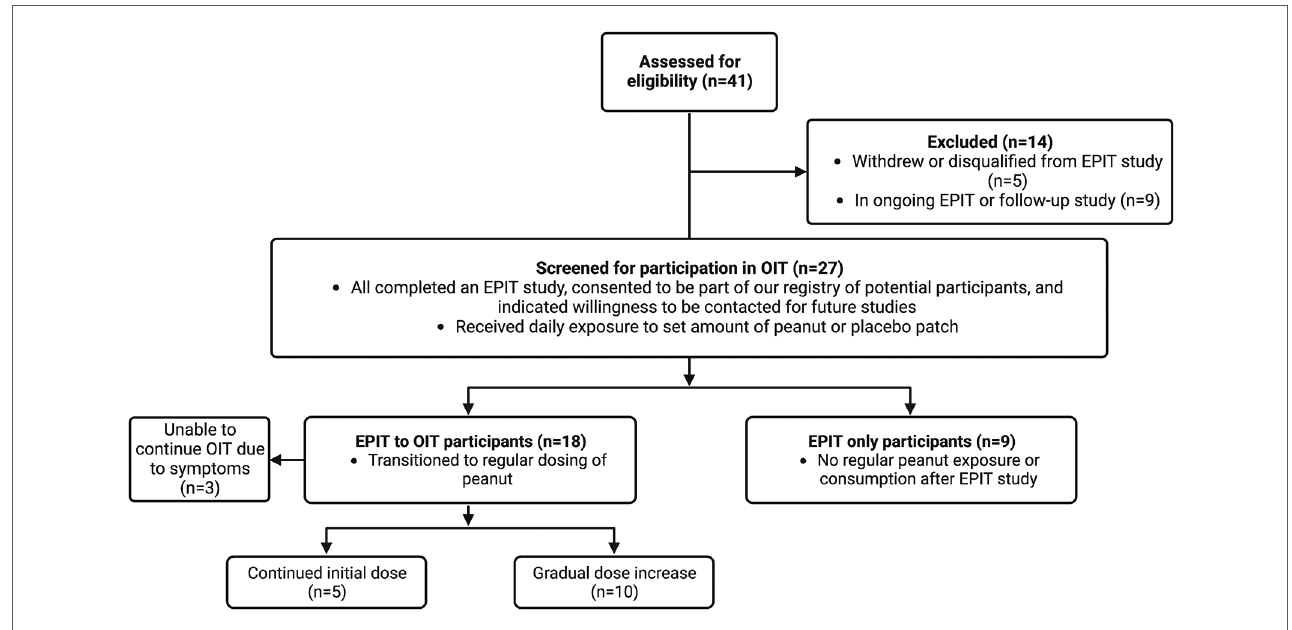
FIGURE 1 Participant progression after completion of EPIT